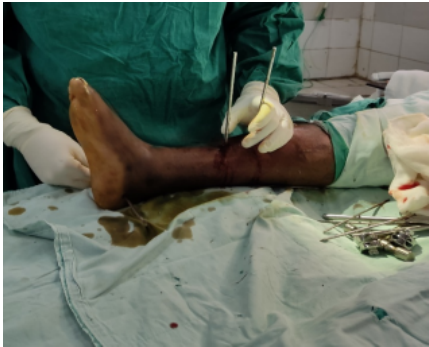
Figure 1. placement of proximal tibia